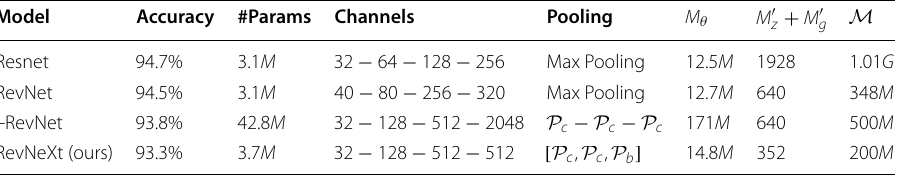
Table 1 Summary of architectures with different levels of reversibility